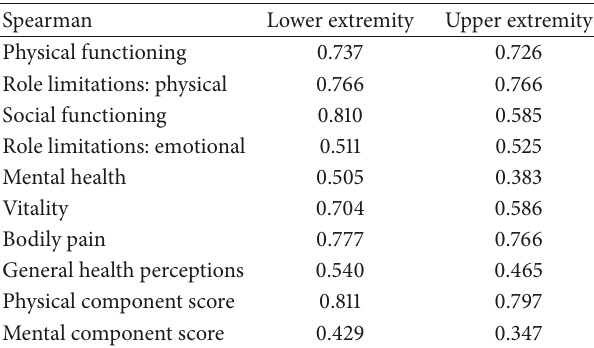
Table 3: Construct validity. Spearman rank correlations of the TESS (upper and lower extremities) with the SF-36 dimensions.